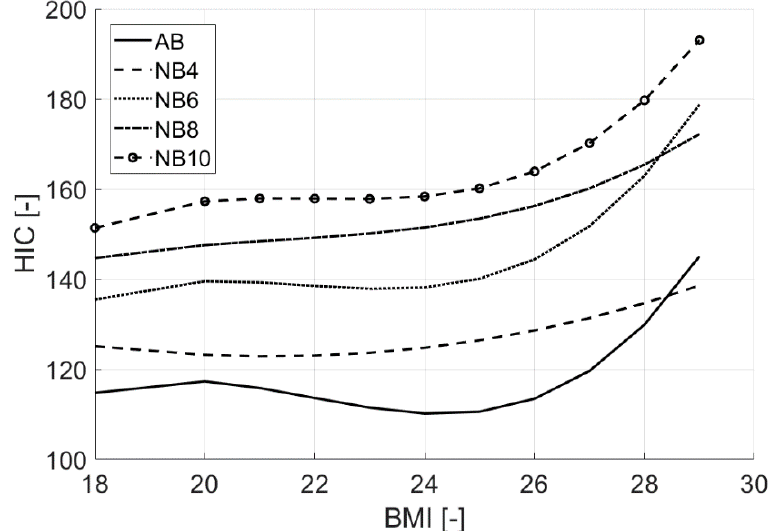
Figure 5. BMI vs HIC plots for 30 km/h